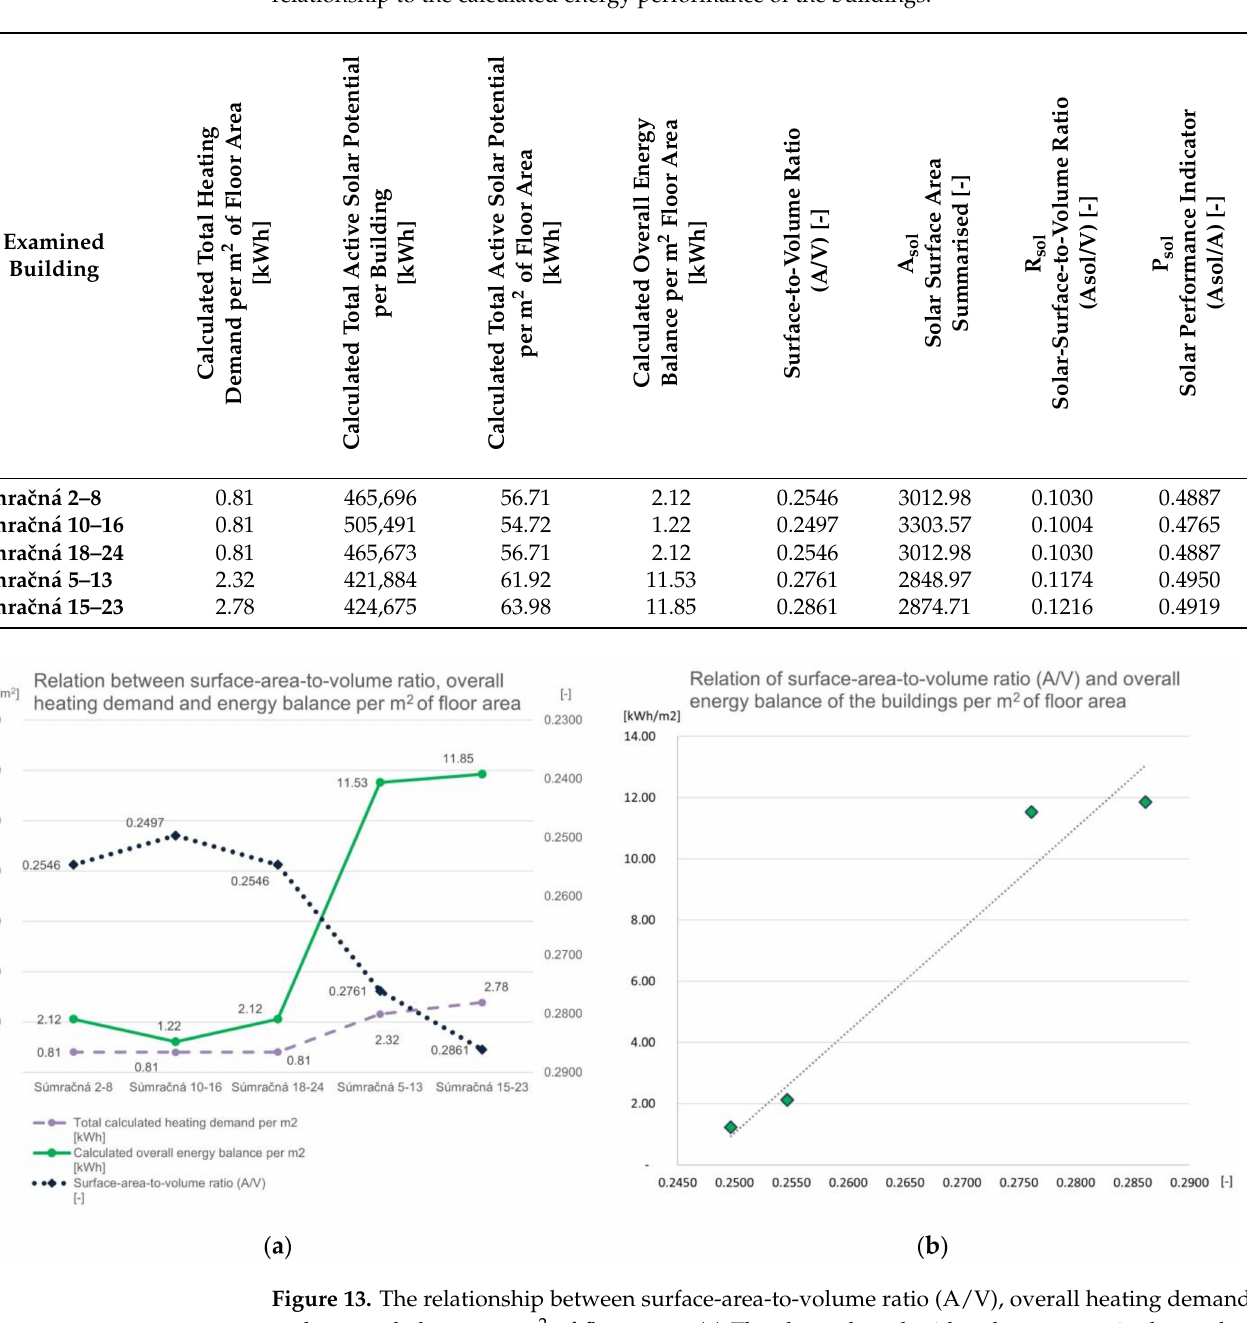
Table 6. An overview of the calculated energy demands and potentials related to floor area in the case of a deep renovation of five residential buildings in the Ostredky housing estate, Bratislava, provides a direct comparison of the energy performance of buildings. In addition, the table shows the values of the easy-to-use building solar potential indicators proposed by the authors and their relationship to the calculated energy performance of the buildings.